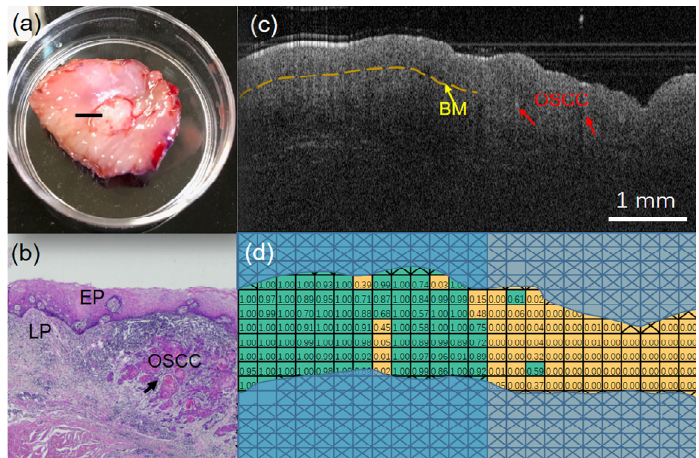
Figure 6. OCT imaging and prediction results at the junction between normal mucosa and OSCC. ( a ) is a photograph of the excised tissue. ( b ) is the corresponding histopathological image with the normal region on the left and the cancerous region on the right. ( c ) is the OCT image at the black line of ( a ). ( d ) is the corresponding prediction visualization.